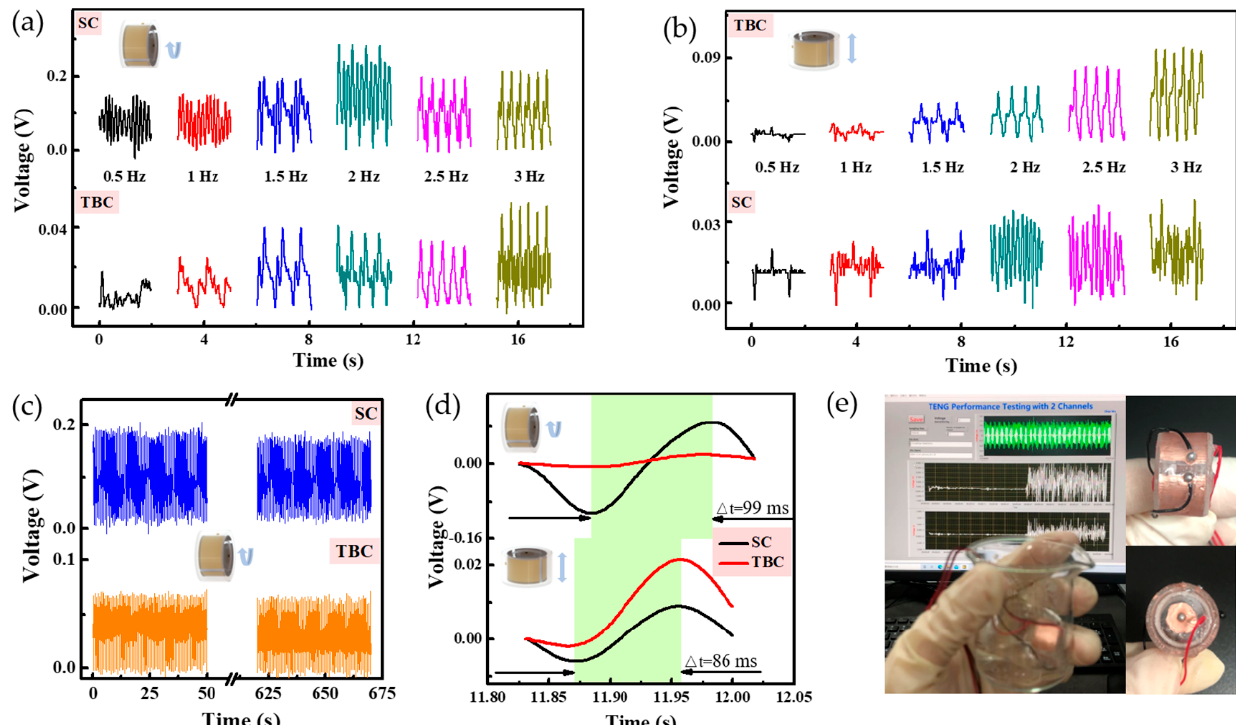
Figure 2. Electrical and mechanical characterization of the SWS. V OC of the SWS at various pressing frequencies in different moving directions. ( a ) Circumference direction; and ( b ) top and bottom direction. ( c ) The mechanical durability characterization of the SWS with 1000 continuous working cycles at 1.5 Hz. ( d ) Response time of the V OC when the external stimulus was applied and released at the acceleration of 1.7 m/s 2 . ( e ) Water resistance of the SWS.